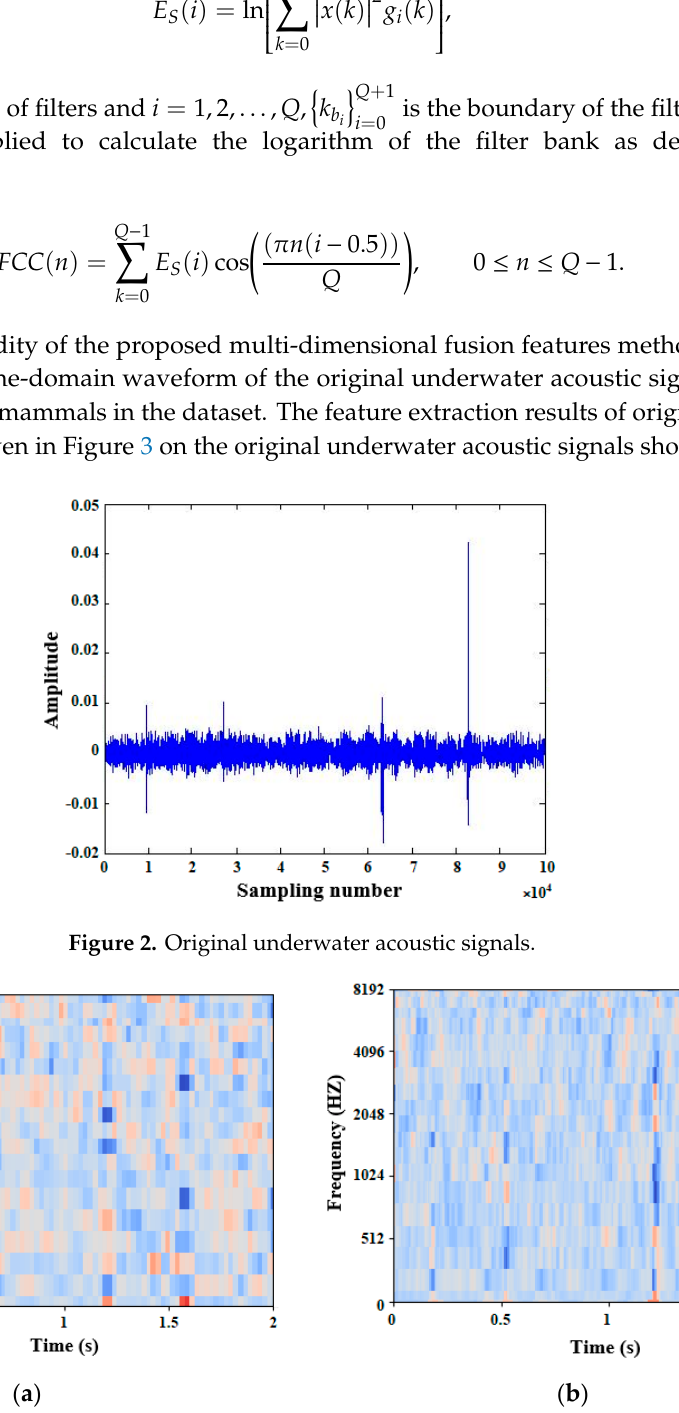
Figure 3. Features extraction results of the original underwater acoustic signals: ( a ) Features of the Mel frequency cepstral coefficient (MFCC) in original underwater acoustic signals; ( b ) Features of the GFCC in original underwater acoustic signals.